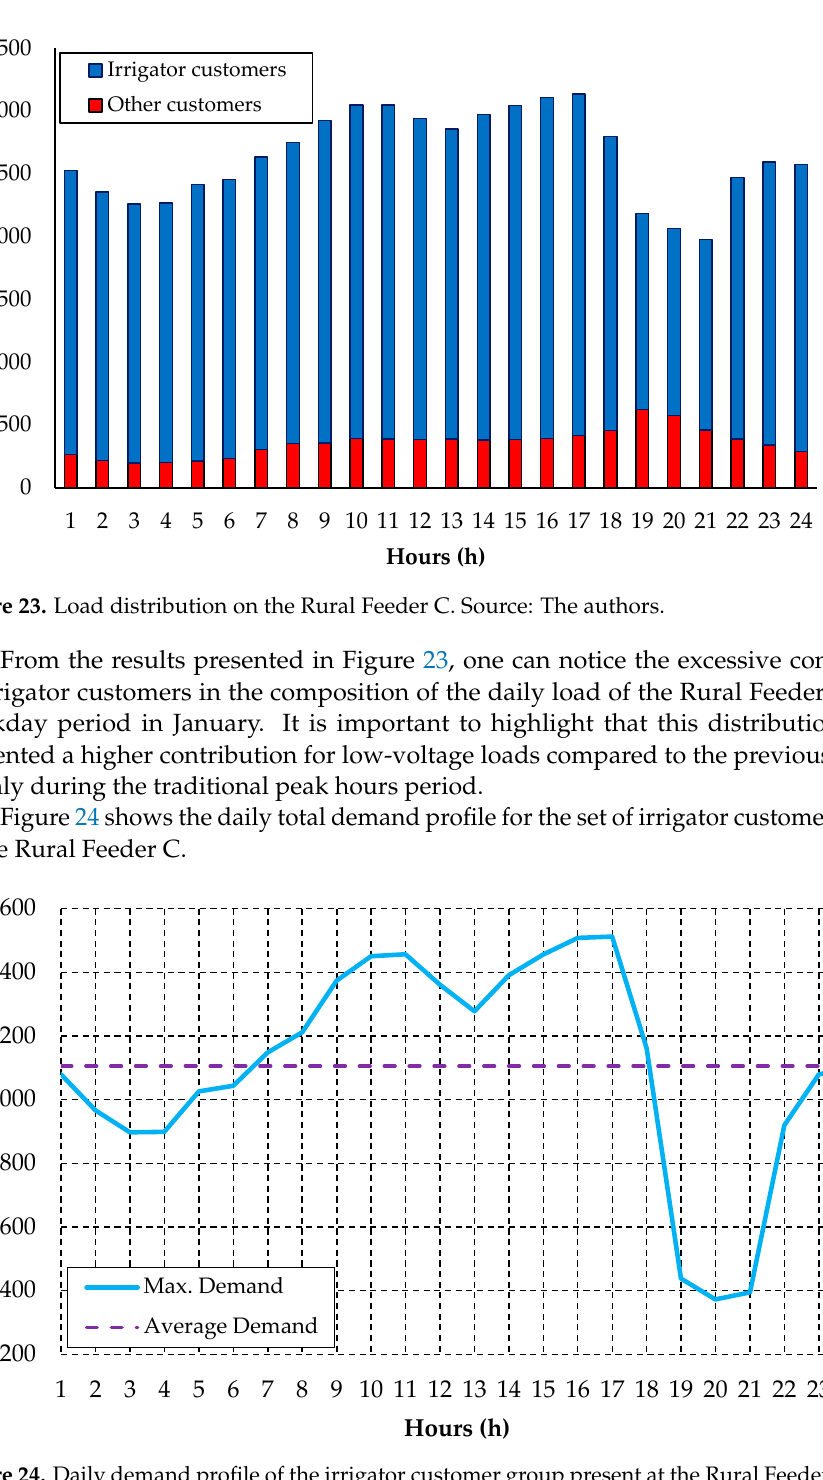
Figure 24. Daily demand profile of the irrigator customer group present at the Rural Feeder C. Source: The authors.